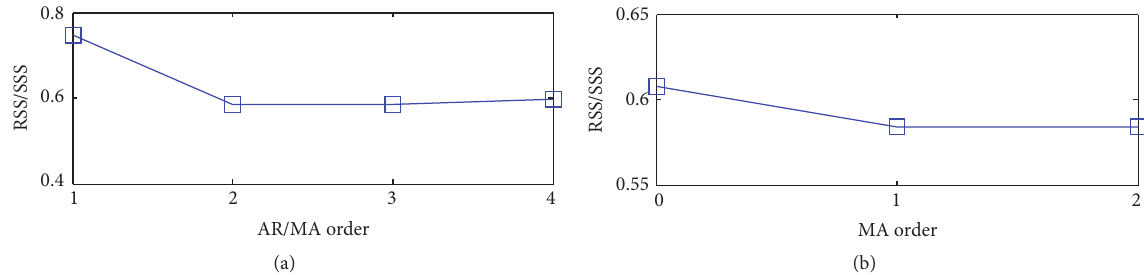
Figure 2: RPLR-FS-TARMA model order selection: (a) AR order and (b) MA order.